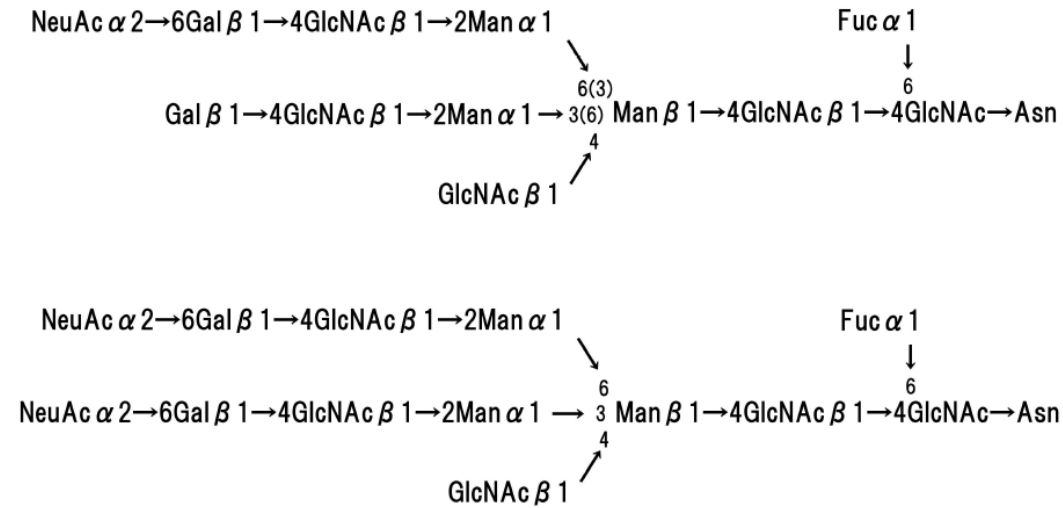
Figure 6. Basic structure of N-linked oligosaccharides of glycophorin A.